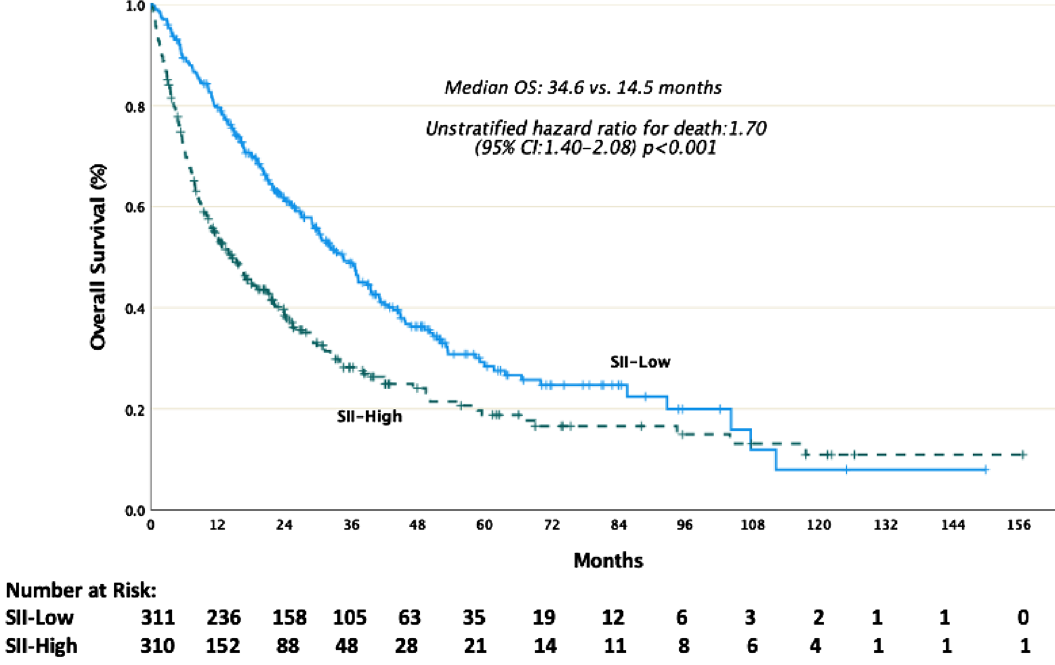
Figure 1. Kaplan-Meier estimates of overall survival (OS). SII systemic immune inflammation index.